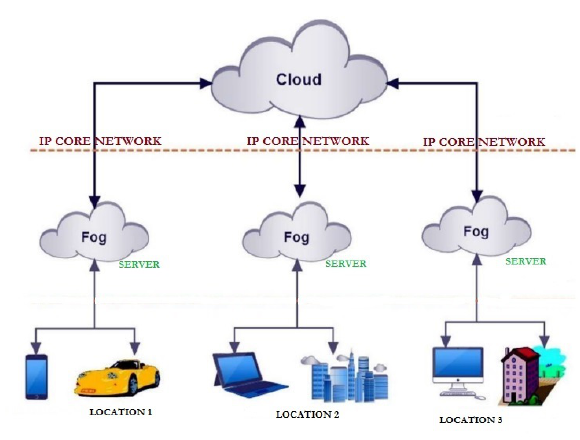
Fig. 1. Cloud-Fog-IoT